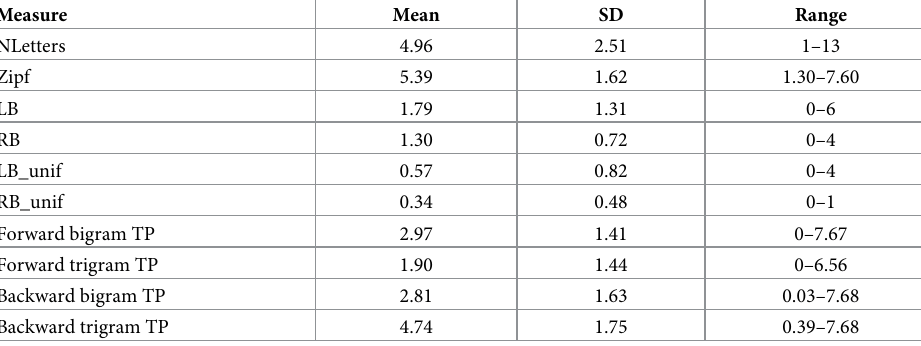
Table 2. Descriptive statistics of word-level